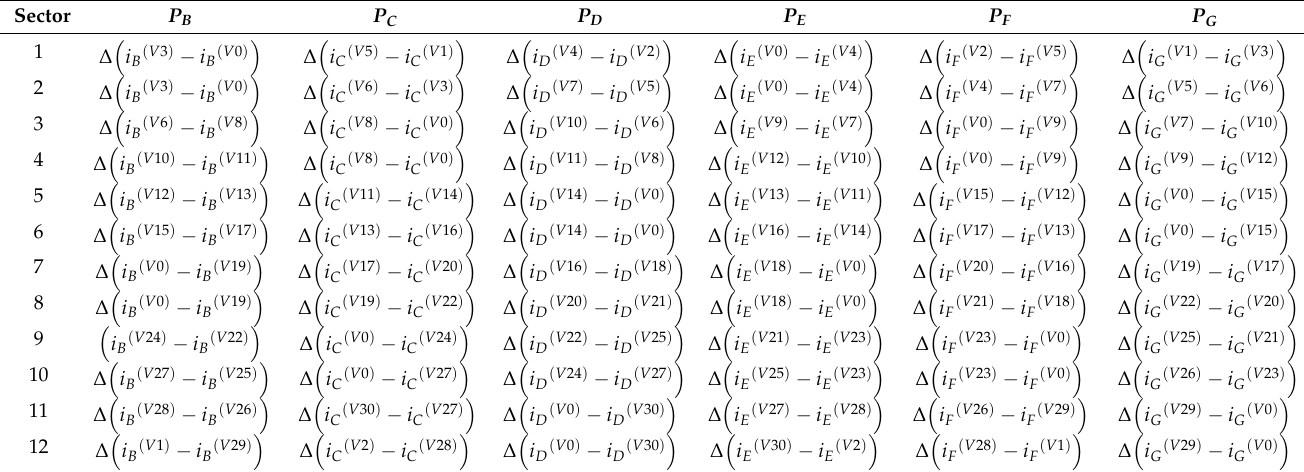
Table 3. Selection of the saliency position scalars after losing phase ‘A’ at different